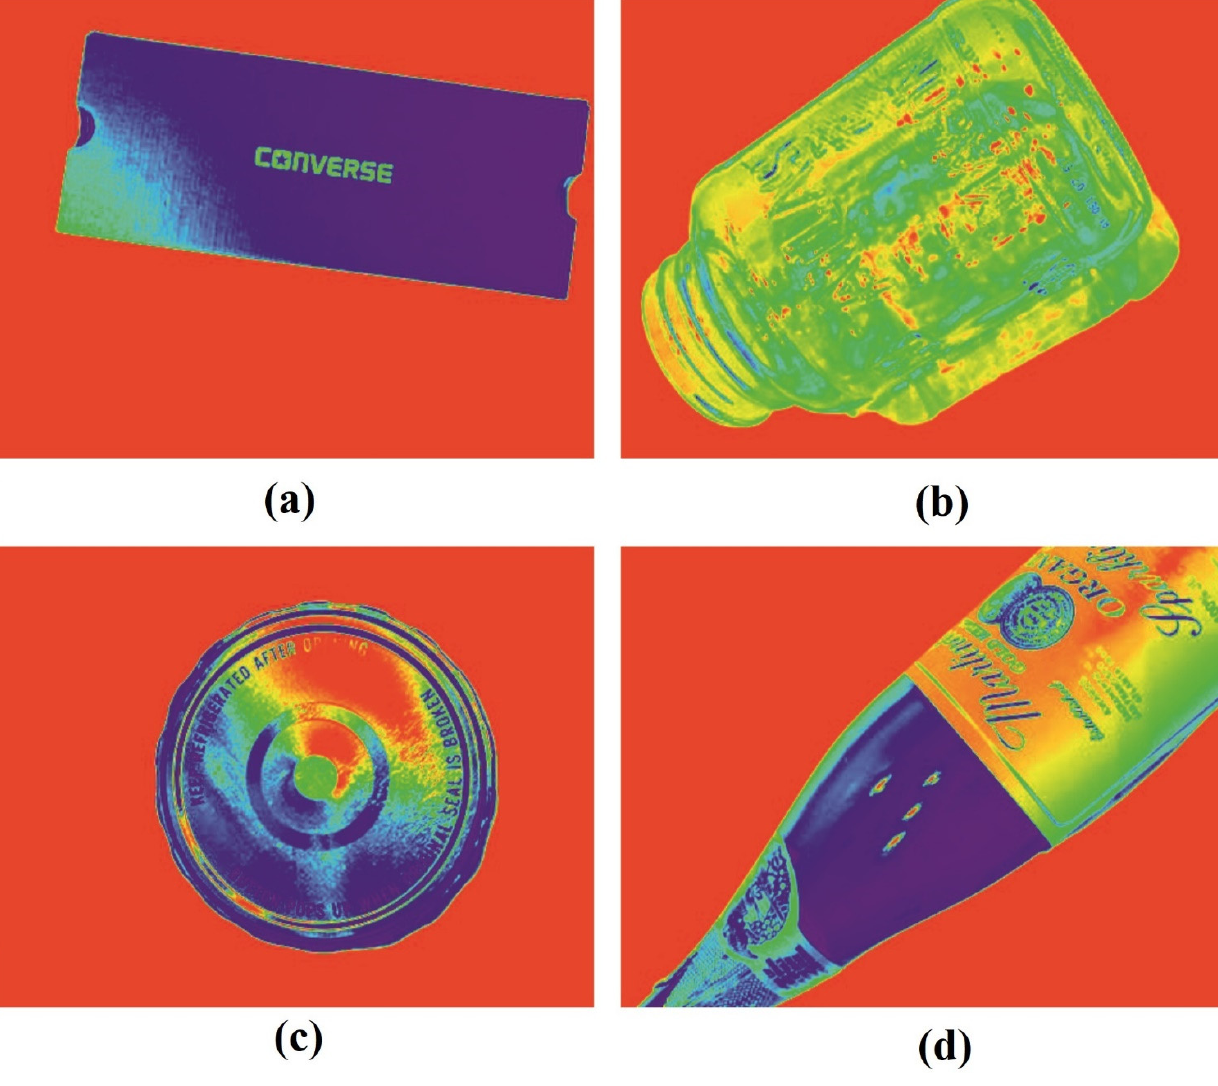
Figure 3. Heat map analysis. ( a ) Cardboard, ( b – d ) glass.